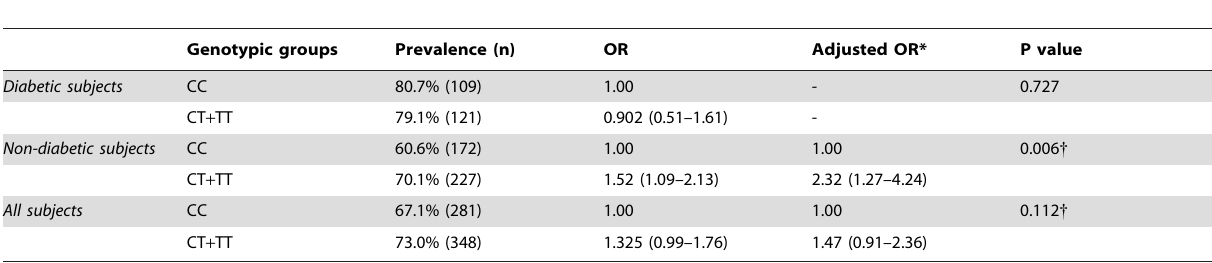
Table 2. Prevalence and risk estimative of coronary lesions according to TCF7L2